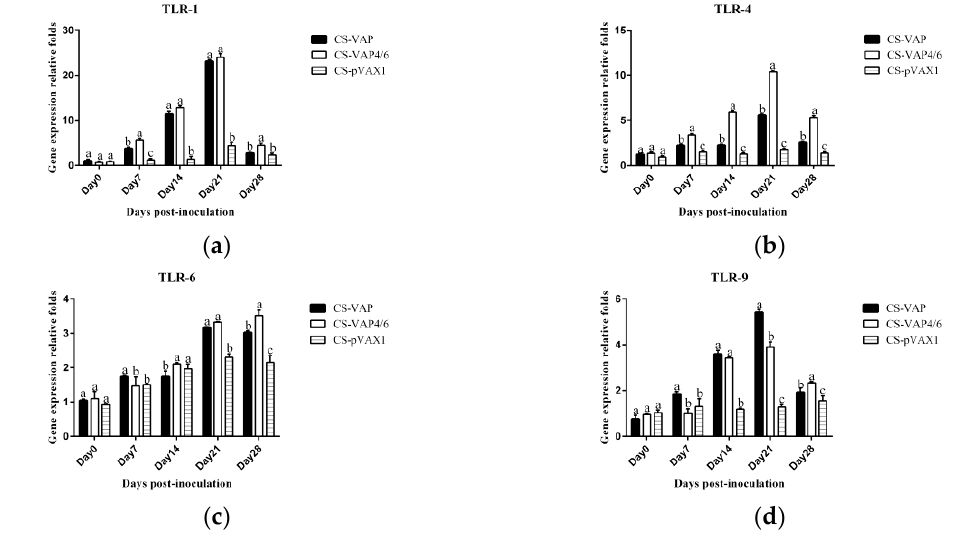
Figure 8. Changes of four toll-like receptor (TLR) genes in blood of experimental mice. The expression of TLR1 ( a ), TLR 4 ( b ), TLR 6 ( c ), and TLR9 ( d ) increased markedly in CS-VAP and CS-VAP4/6 in different days post-inoculation compared with CS-pVAX1 ( p < 0.05), and the expressions of these four TLR genes of CS-VPA4/6 were promoted significantly in different periods after inoculation compared with CS-VAP( p < 0.05).